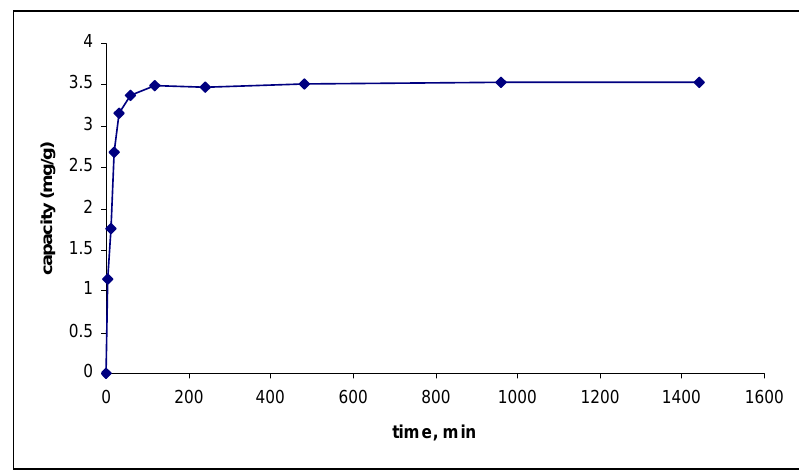
Figure 5. Adsorption rate of 2,4-dinitrophenol by